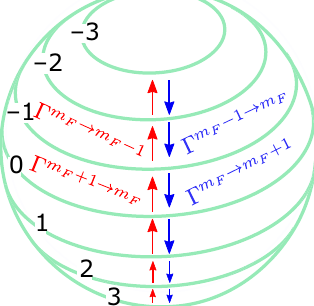
FIG. 7. An illustration of the Cs spin-exchange rate. The Bloch sphere illustrates the seven-level Cs spin system with corre- sponding m F ,Cs numbers. The red (blue) arrows present the rates between two neighboring states for the heating (cooling)